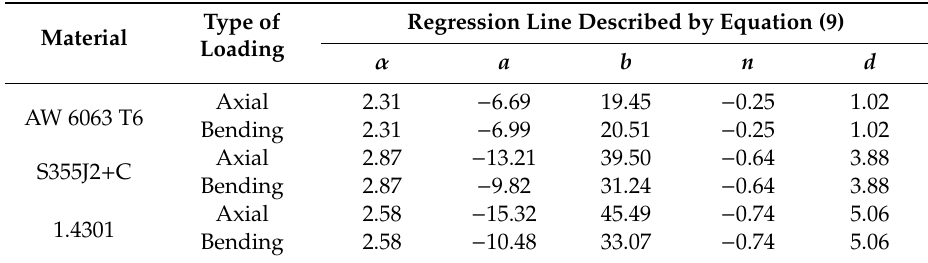
Table 2. Fatigue characteristic S-N parameters.